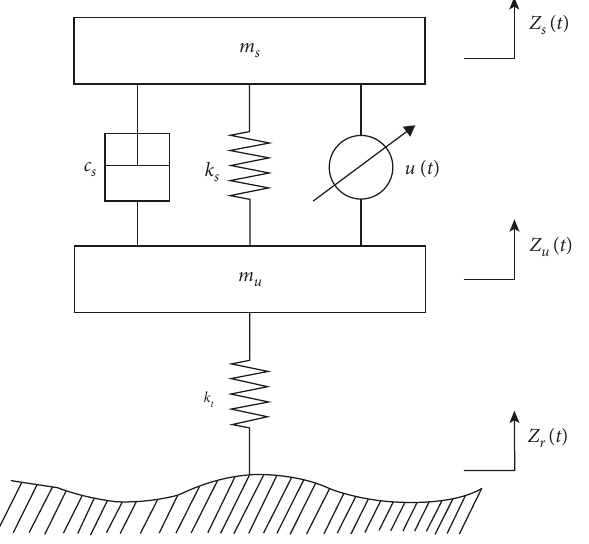
Figure 1: Quarter-car active suspension